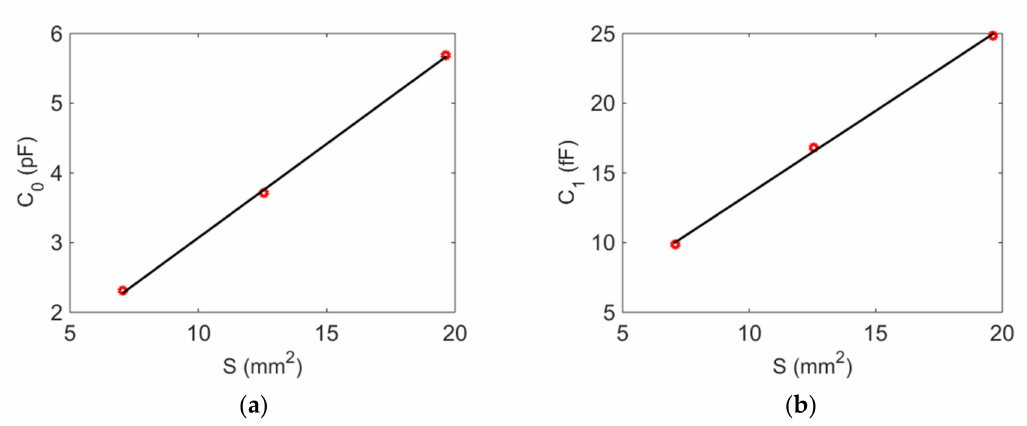
Figure 7. The linear relationship between electrode area and both C 0 and C 1 : ( a ) S vs. C 0 ; ( b ) S vs. C 1